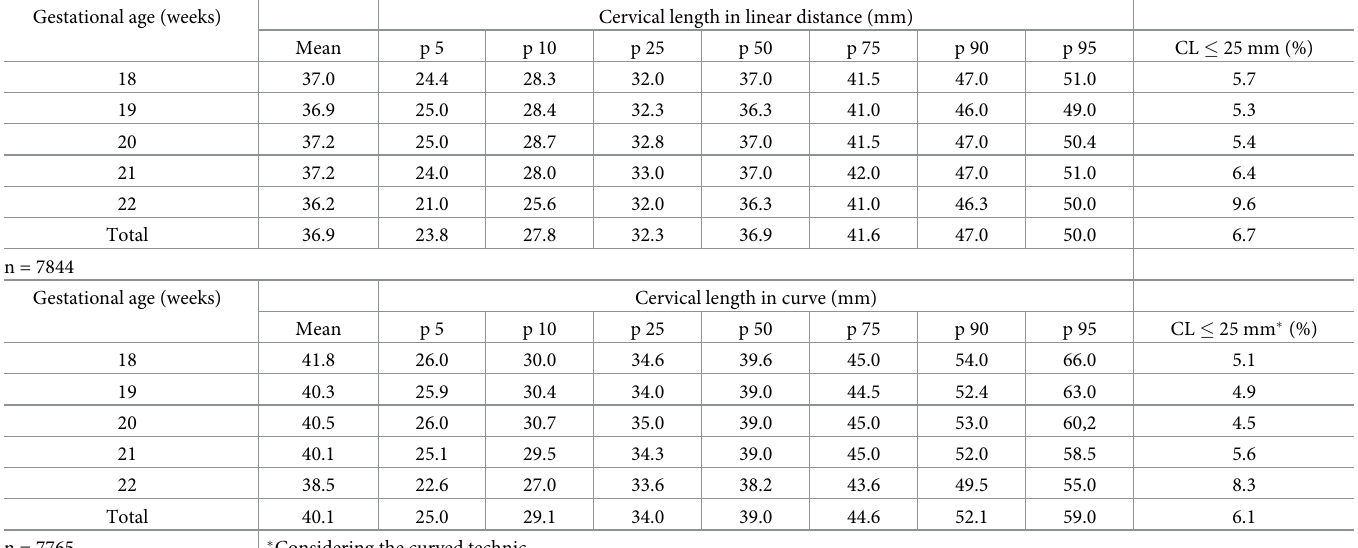
Table 2. Values of percentile 5, 10, 25, 50, 75, 90 e 95 for the cervical length measurement in linear distance between internal and external os and in curve by ultraso- nography according to gestational age. Gestational age